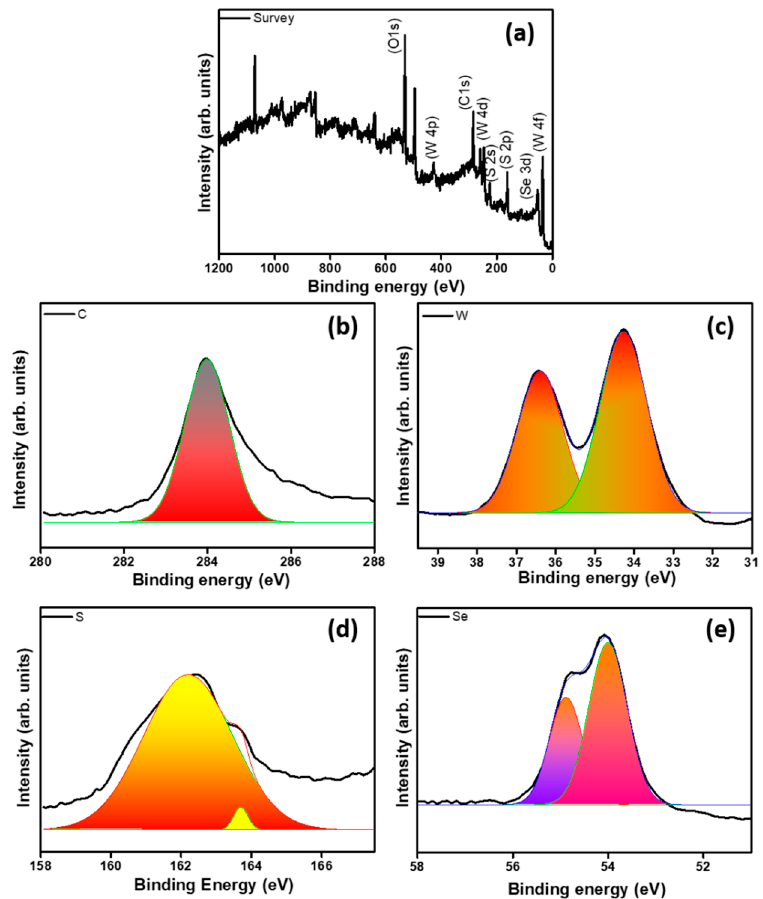
Figure 5. X-ray photoemission spectroscopy scan for WS (1 − x ) Se x /graphene/NF. ( a ) Survey scan; ( b ) C, ( c ) W; ( d ) S and ( e ) Se binding energies.